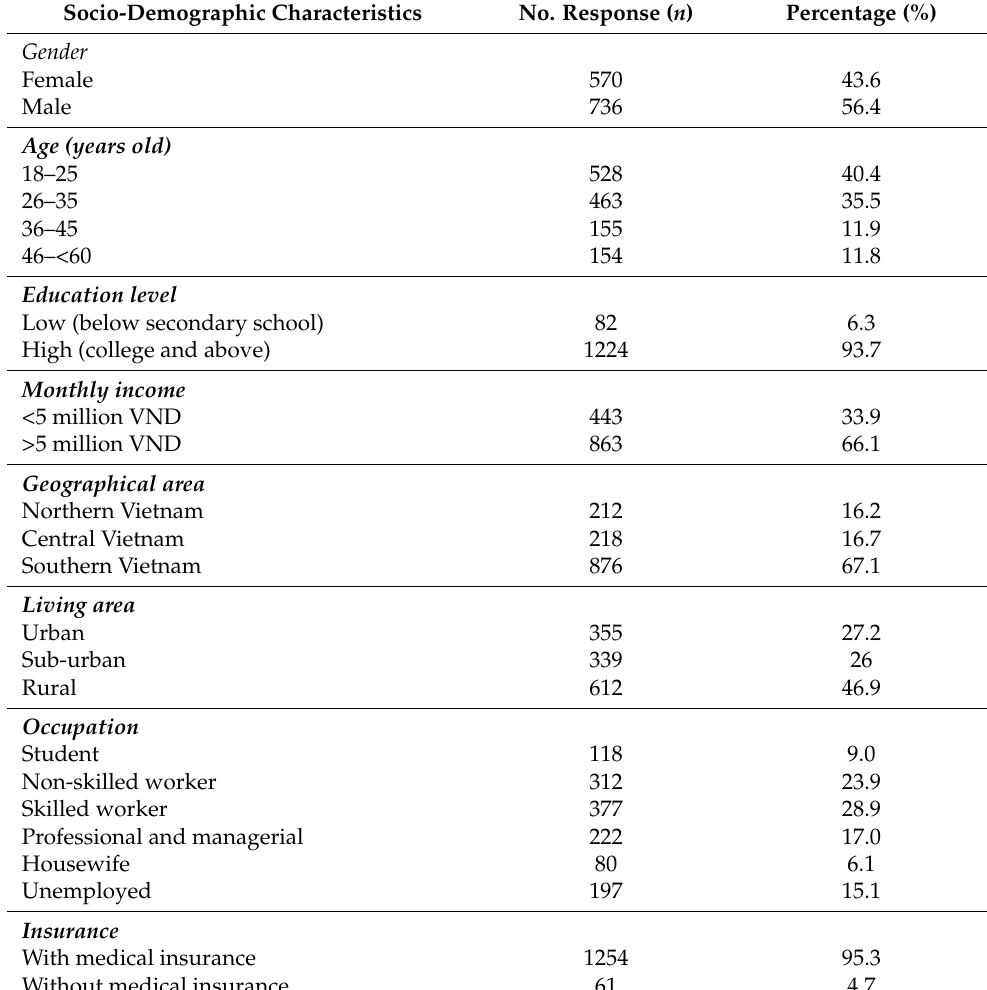
Table 1. Socio-demographic characteristics of the respondents in Vietnam ( n =